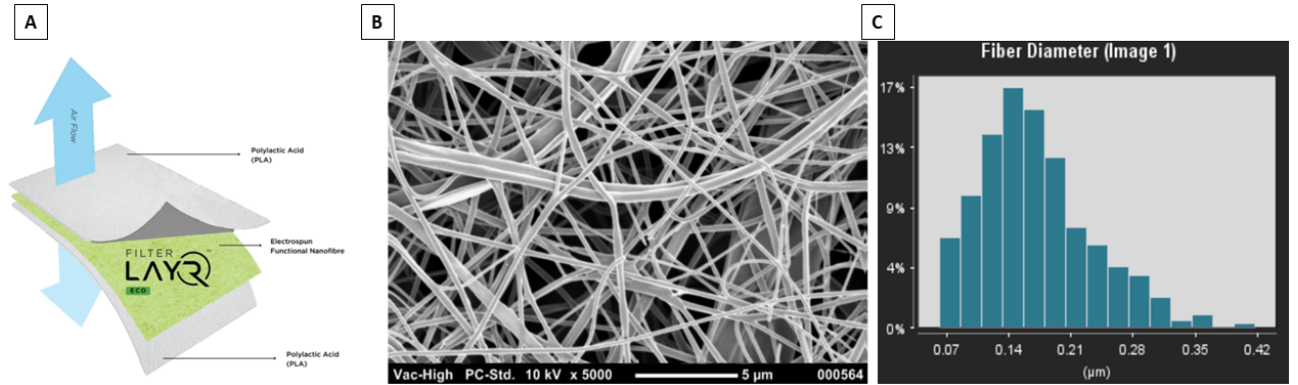
Figure 1. ( A ) Diagram of FilterLayr TM Eco structure spun ‐ bond PLA/PLA electrospun nano ‐ fibre/spun ‐ bond PLA; ( B ) Scanning electron micrograph of nanofibre layer made from PLA; and ( C ) average fibre distribution of PLA electrospun fibres using Fibraquant image analysis software.